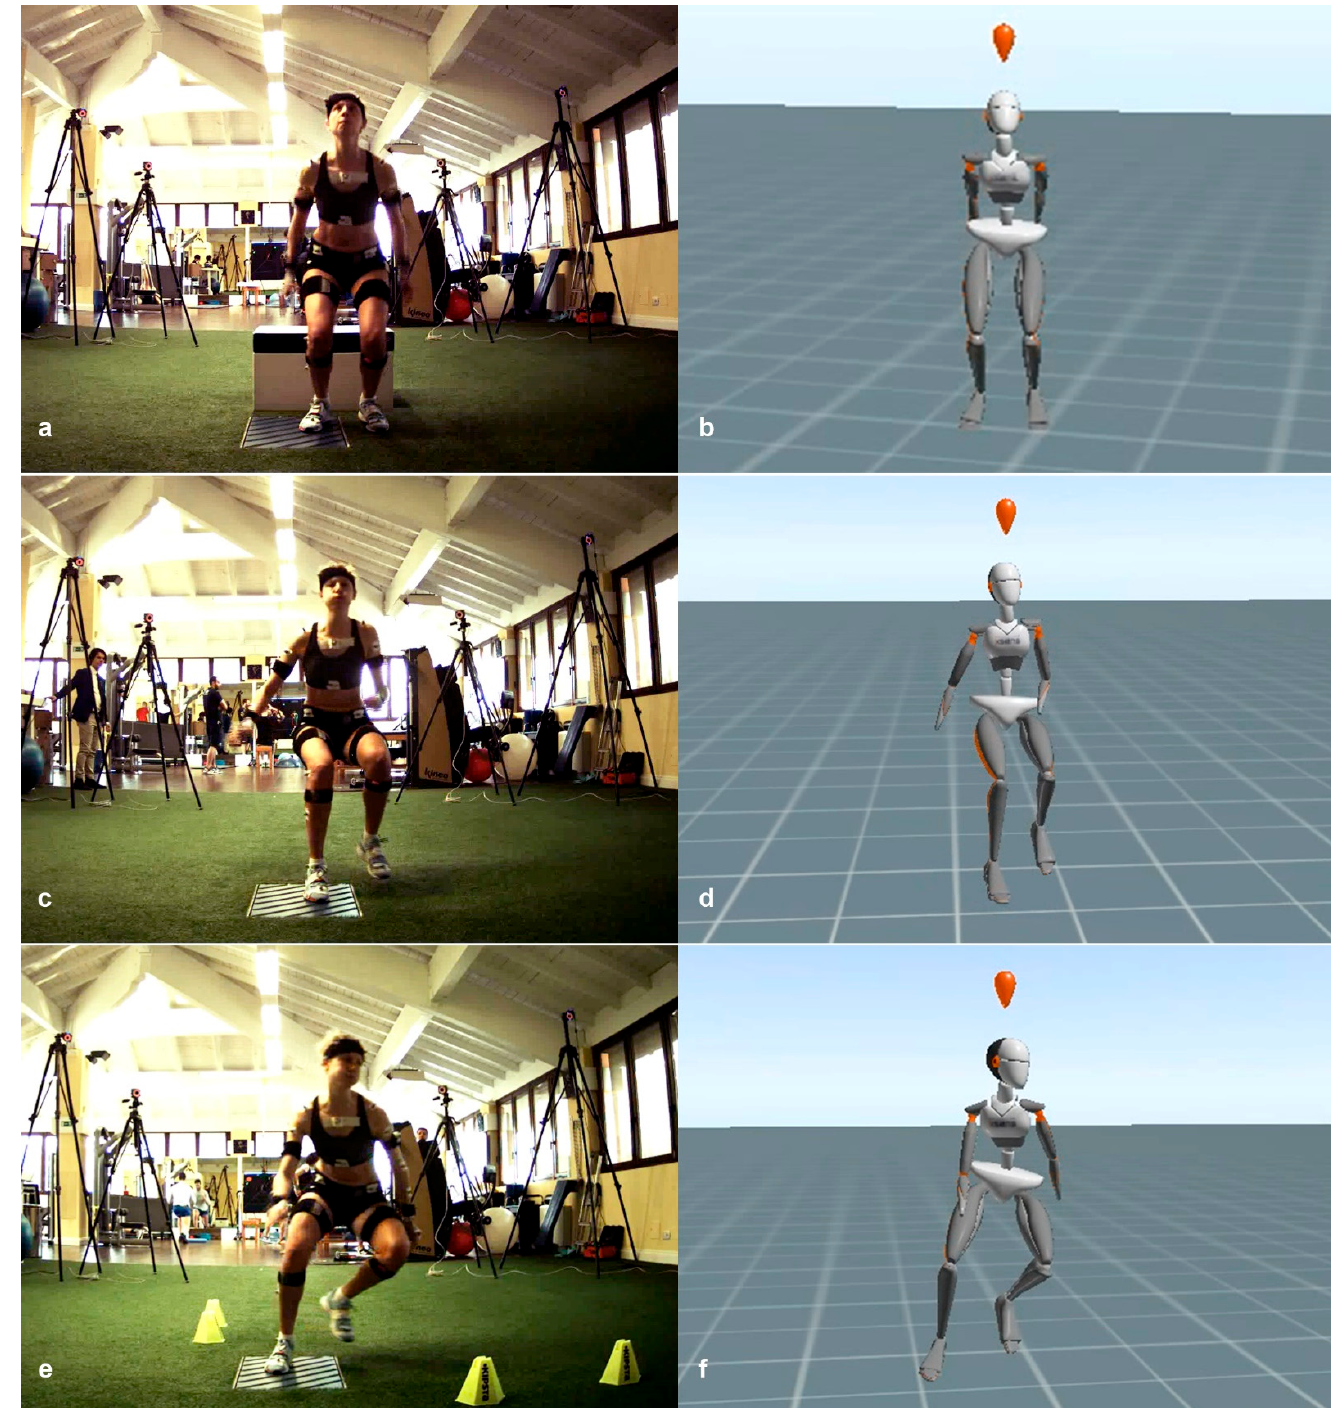
Figure 1. Representation of the three motor tasks performed by the athletes and used for comparative analysis alongside the real-time movement reconstruction in the wearable sensor software environment: ( a , b ) the drop jump (DJ); ( c , d ) the forward sprint (FS); ( e , f ) the change of direction at 90° (CD).